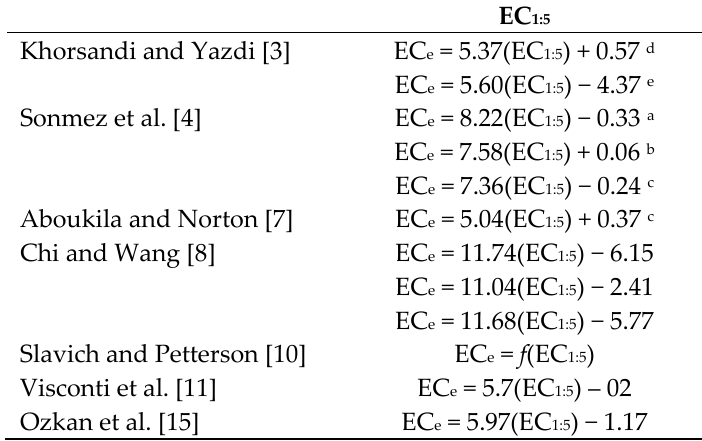
Table 2. The EC e = f (EC 1:5 ) relationship proposed by several researchers. The indices a , b , c refer to coarse, medium and fine soils respectively. The indices d and e refer to the cases where gypsum is present and not present respectively. The equation of [11] refers to a gypsum mass percentage <0.2%. Chi and Wang [8] presented cases considering the range of θ SP variation. Their first equation corresponds to a range of θ SP between 20% and 45% while their second equation between 45 and 63%. The third equation corresponds to the full range of θ SP of variation i.e., between 20% and